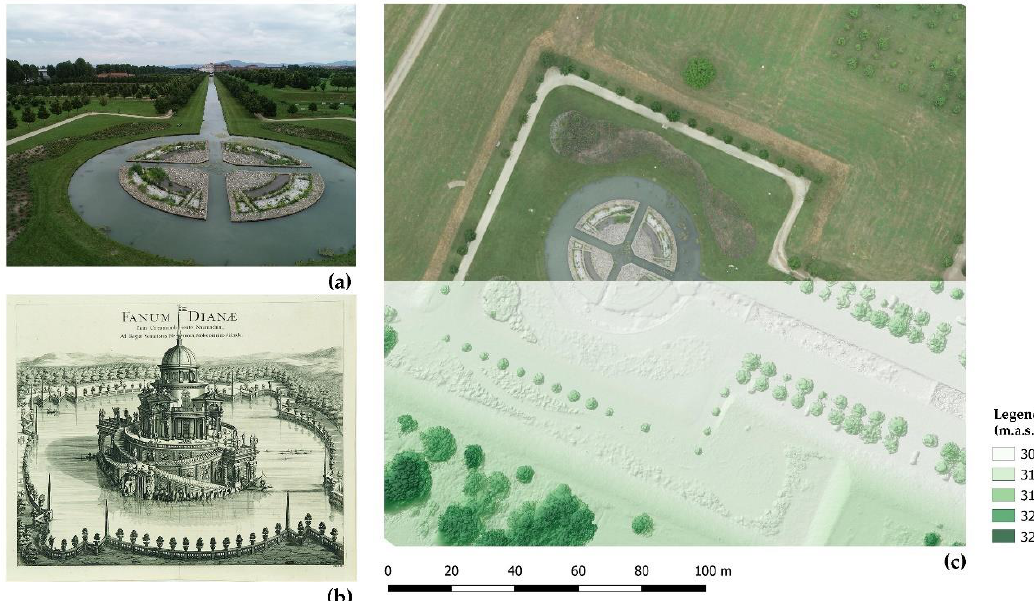
Figure 1. The area of the Temple of Diana. An aerial image of the area ( a ), an 18th century representation ( b ) and an extract of DSM and orthoimage of the area ( c ).